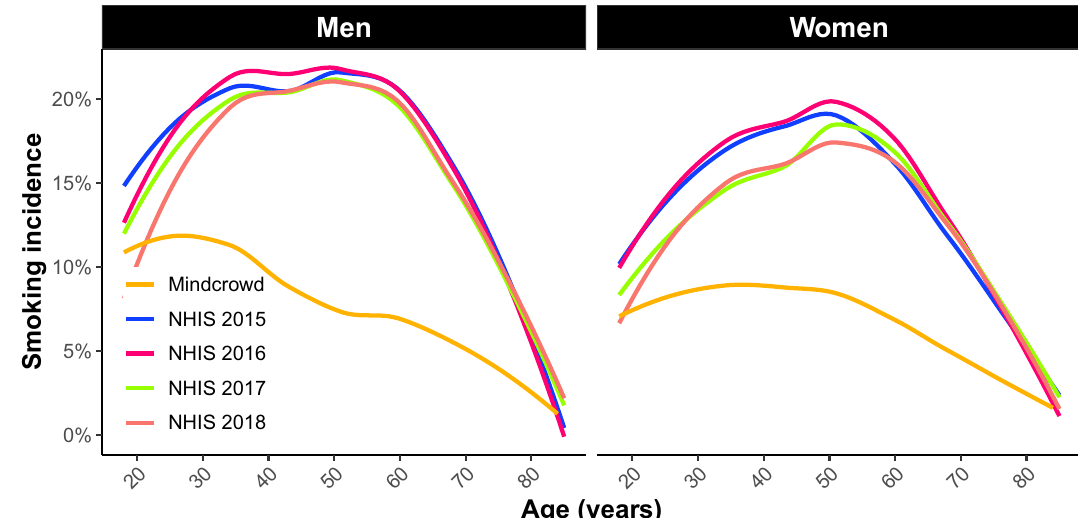
Figure 9. A visual representation of US smoking rates by age derived from data from the National Health Interview Study (NHIS) for years 2015–2018 and MindCrowd smoking rates per age for men and women. The NHIS is is one of the major household survey-based data collection programs of the National Center for Health Statistics (NCHS) which is part of the Centers for Disease Control and Prevention (CDC). These data demonstrate that men typically have higher smoking rates compared to women of the same age and that MindCrowd, while demonstrating lower rates of smoking overall, follows the same trend as observed by the